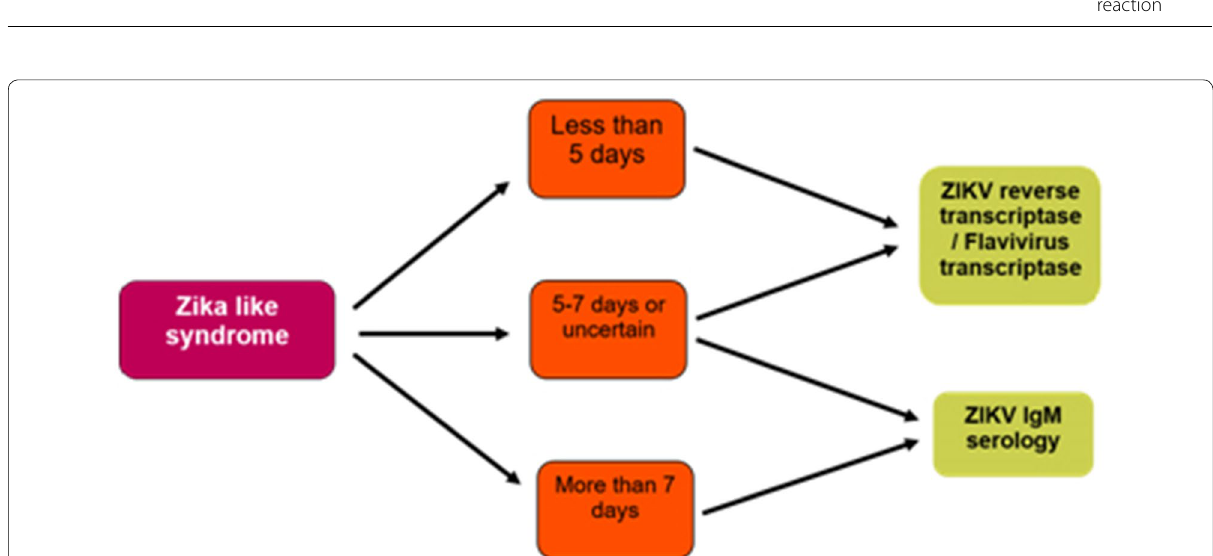
Fig. 5 Flow scheme for ZIKV fever diagnosis [73,